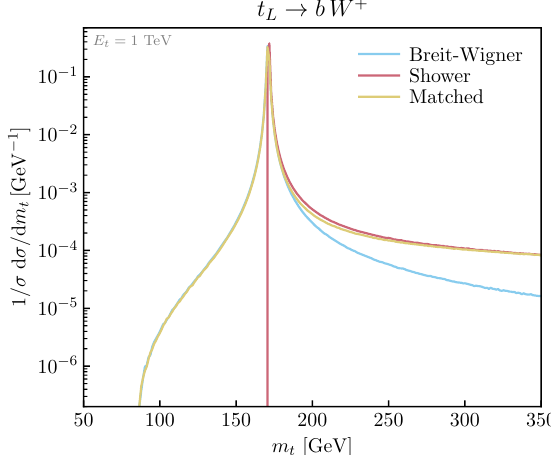
Figure 4: The mass spectrum of a 1 TeV left-handed top quark decay as generated by the Breit-Wigner distribution only (blue), the EW shower (red) and the numeri- cally matched procedure (yellow). The matched spectrum shows a smooth transition between the Breit-Wigner region close to the pole mass, and the parton-shower dis- tribution far away from